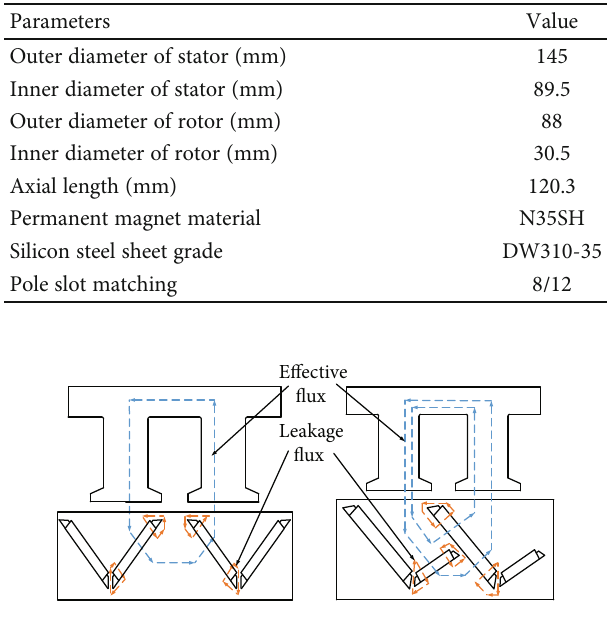
Figure 2: Comparison diagrams of fl ux